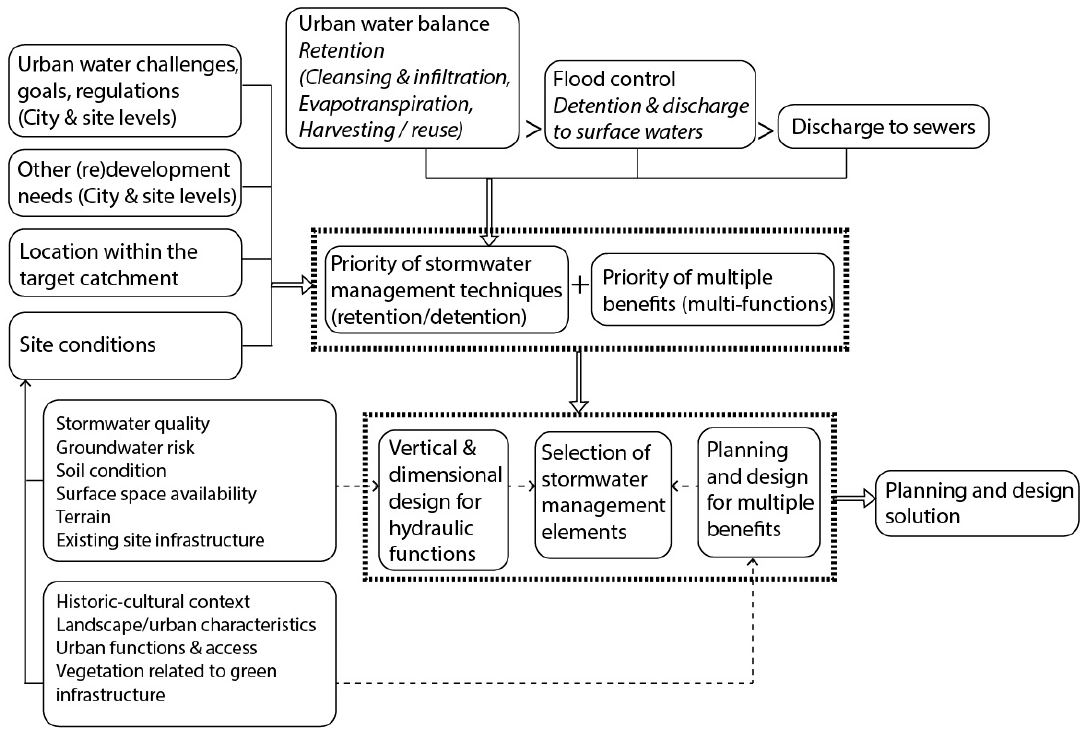
Figure 1. Key considerations for planning and design of blue-green infrastructure for stormwater management project.